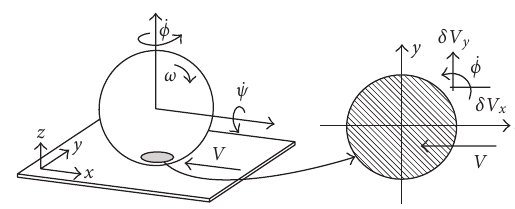
Figure 2: Overview of the rolling motion.